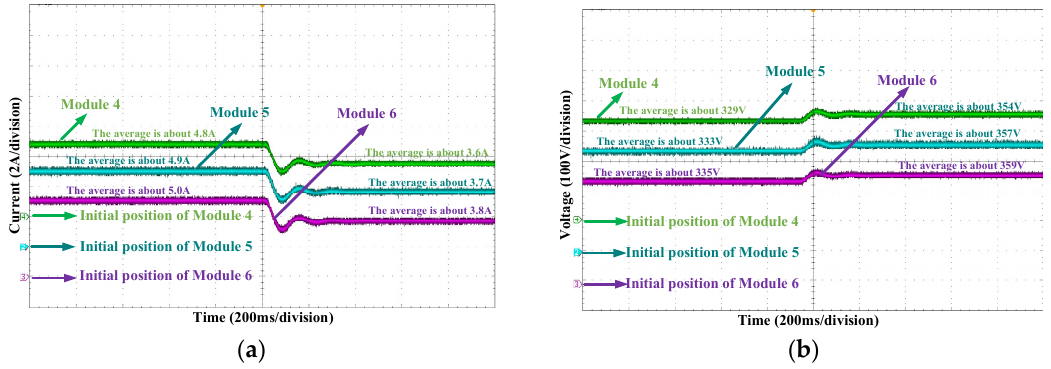
Figure 16. The experimental results of combined converter 2: ( a ) input current of the modules and ( b ) output voltage of the modules.